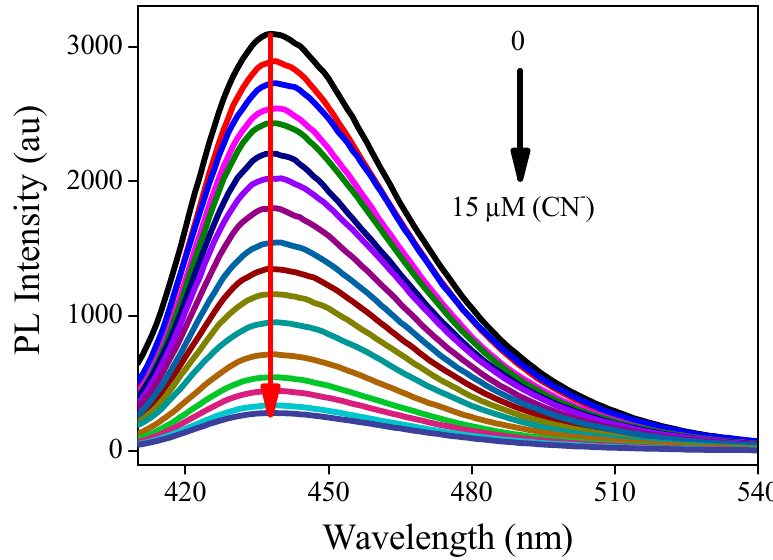
Figure 7. Fluorescence titration spectra of L–Cu 2+ complex (10 µ M) with increasing CN − concentra- tion (0–15 µ M) in ethanol–water ( v / v = 7/3, 5 mM HEPES, pH 7.0) (at λ ex = 380nm with excitation slit = 5 nm and emission slit = 5 nm).